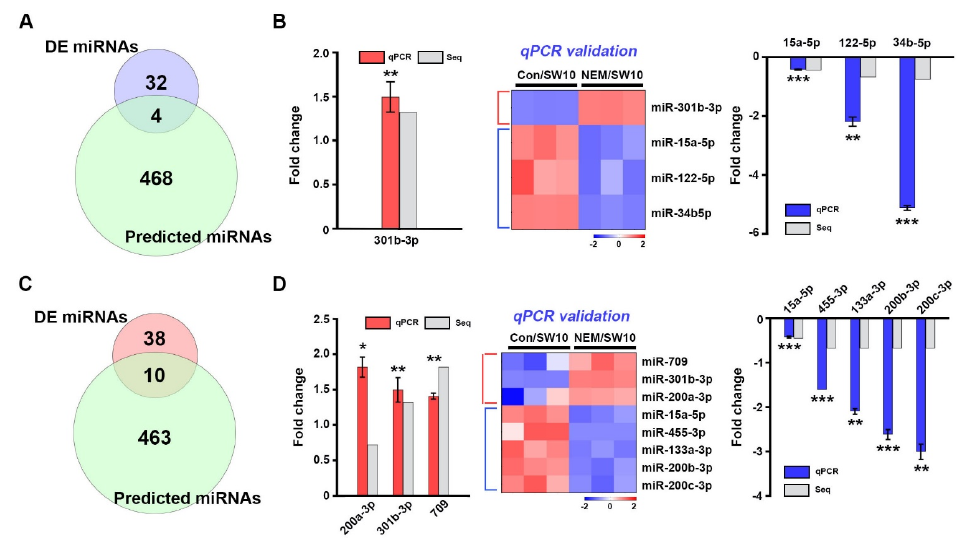
Figure 6. Interaction among oxidative stress genes, transcription factors, and miRNAs in the post- transcriptional regulation ( A ) Venn diagram analysis of differentially expressed (DE) miRNAs from our RNA-sequencing (Seq) and miRNAs targeting oxidative stress genes predicted by miRWalk2.0. ( B ) One upregulated miRNA and three downregulated miRNAs were validated by qPCR. Heatmap shows the relative expression levels of the miRNAs. ( C ) Venn diagram analysis of differentially expressed (DE) miRNAs from our RNA-sequencing (Seq) and miRNAs targeting transcription factor genes predicted by miRWalk2.0. ( D ) Three upregulated miRNAs and five downregulated miRNAs were validated by qPCR. Heatmap shows the relative expression levels of the miRNAs. Comparisons were performed using a Student’s t -test. * p < 0.05, ** p < 0.01 and *** p < 0.001.